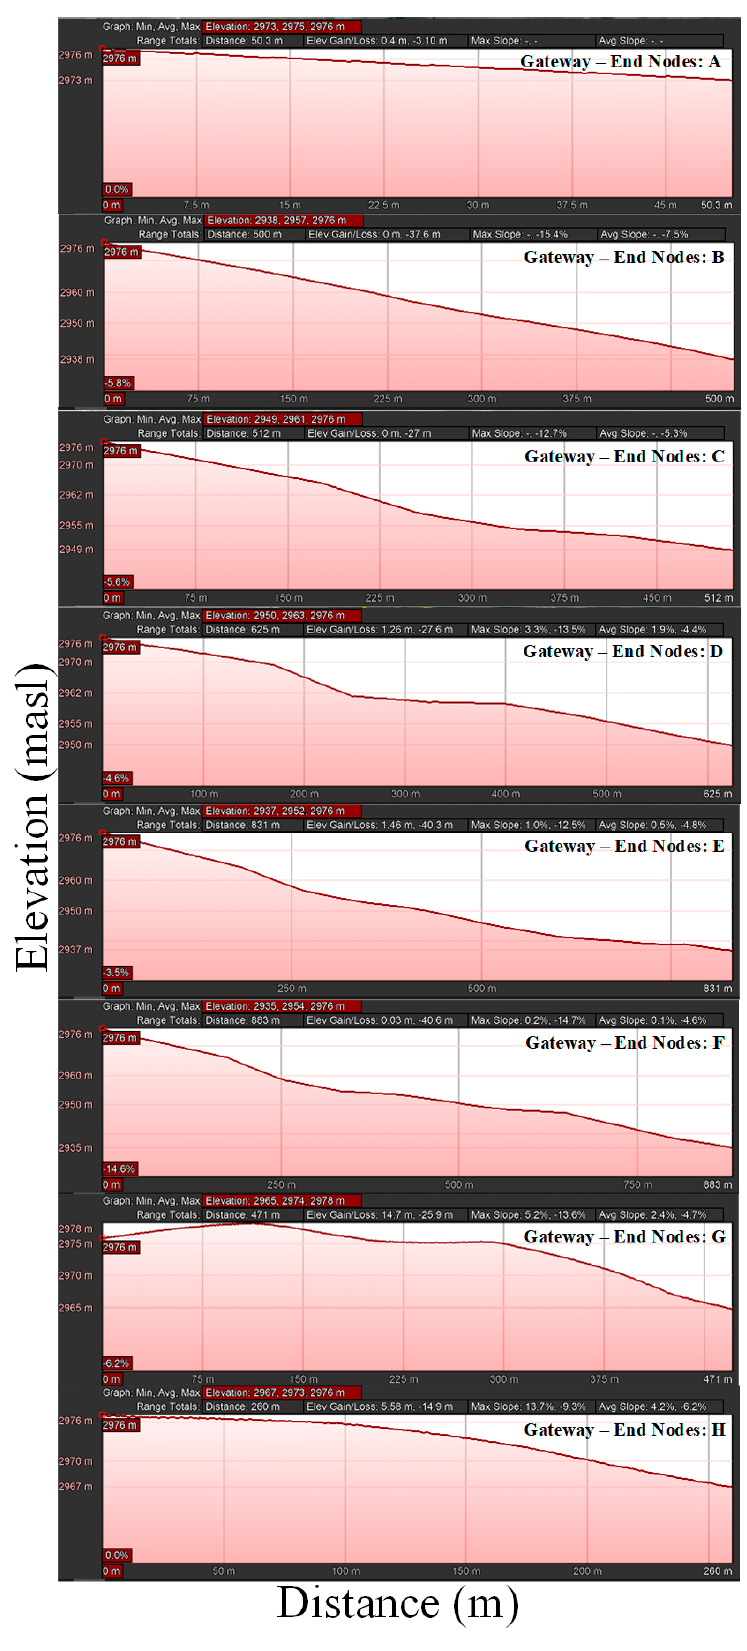
Figure 8. Longitudinal cross-sectional profile of link Nodes—Gateway.